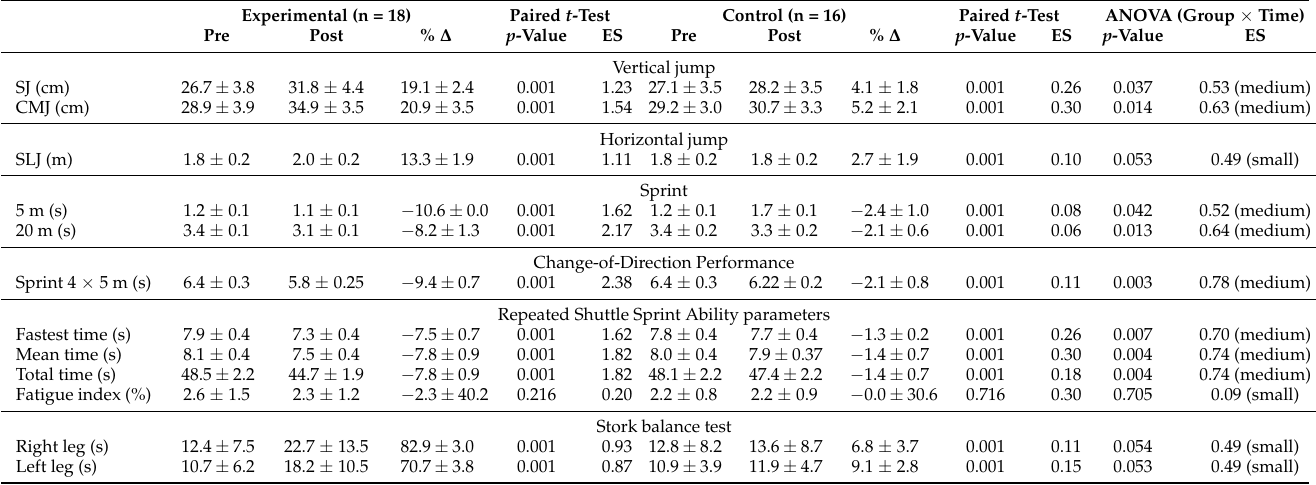
Table 4. Test performances in experimental and control groups before and after 8-week intervention. Experimental (n =